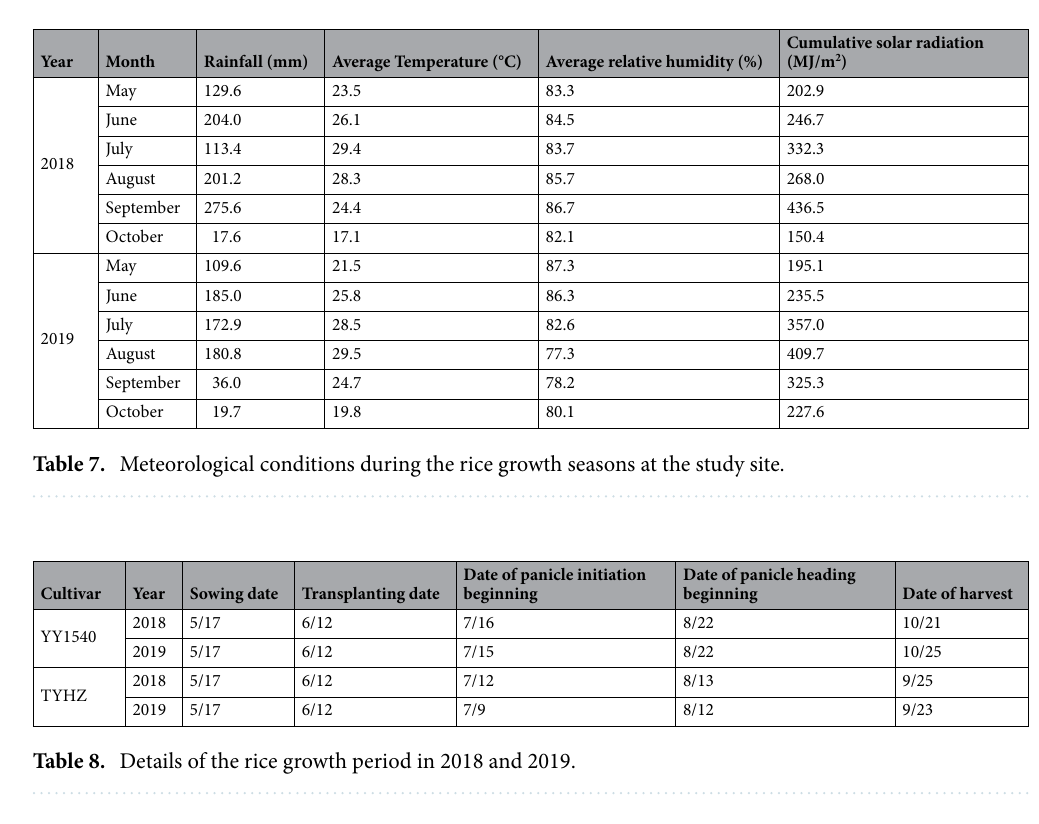
Treatment Traditional nitrogen fertilization with quick-release nitrogen at the 1 days before transplanting (base fertilizer, 40%N), 7 days after transplanting (tillering fertilizer, 30% N) and panicle initiation stage